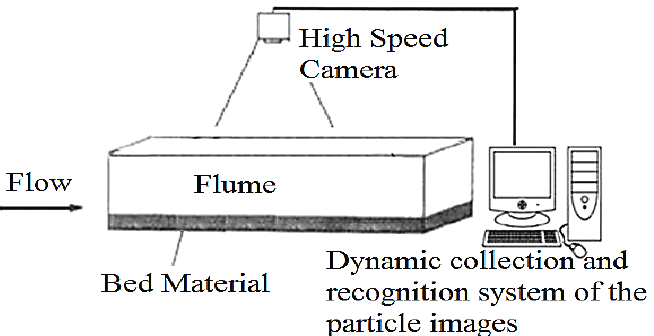
Figure 7. The system comprised two sets of high-speed cameras, the sampling frequencies of which ranged from 20 to 200 Hz. Their resolution was up to 1280 × 1024 pixels. During the experiment’s progress, the images of particles moving near the bed were captured continually. A special program was adopted to process the collected images and identify the particles in the image. The whole process included gray disposal, threshold segmentation, and noise elimination. Finally, the instant compositions of the particles in the sampling area were obtained; in other words, the masses of coarse sands and fine particles in the bed load mixture were acquired. The original image was captured by a high-speed camera, and the recognized images are shown in Figure 8.